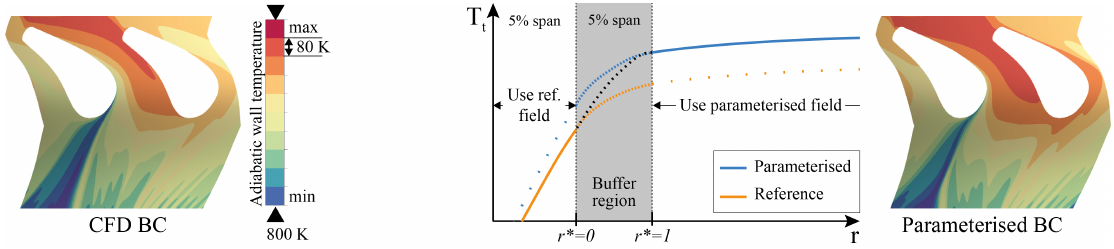
Figure 13. Inclusion of combustor wall film cooling.